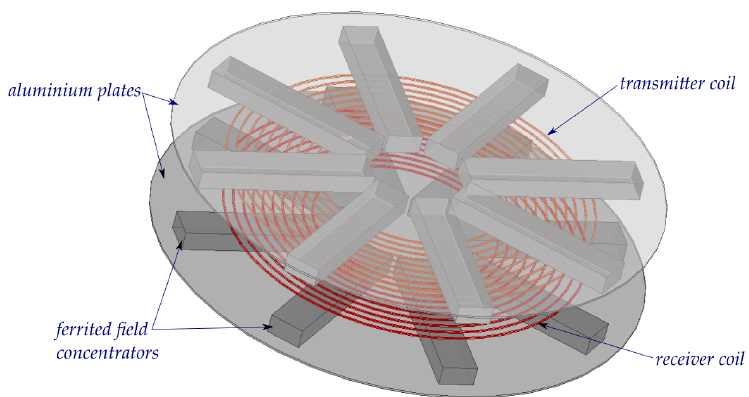
Figure 1. View of considered electromagnetic transducer of a wireless power transfer system (WPTS).